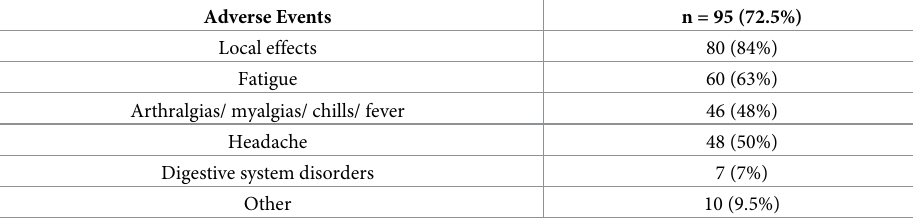
Table 3. Adverse events upon BNT162b2